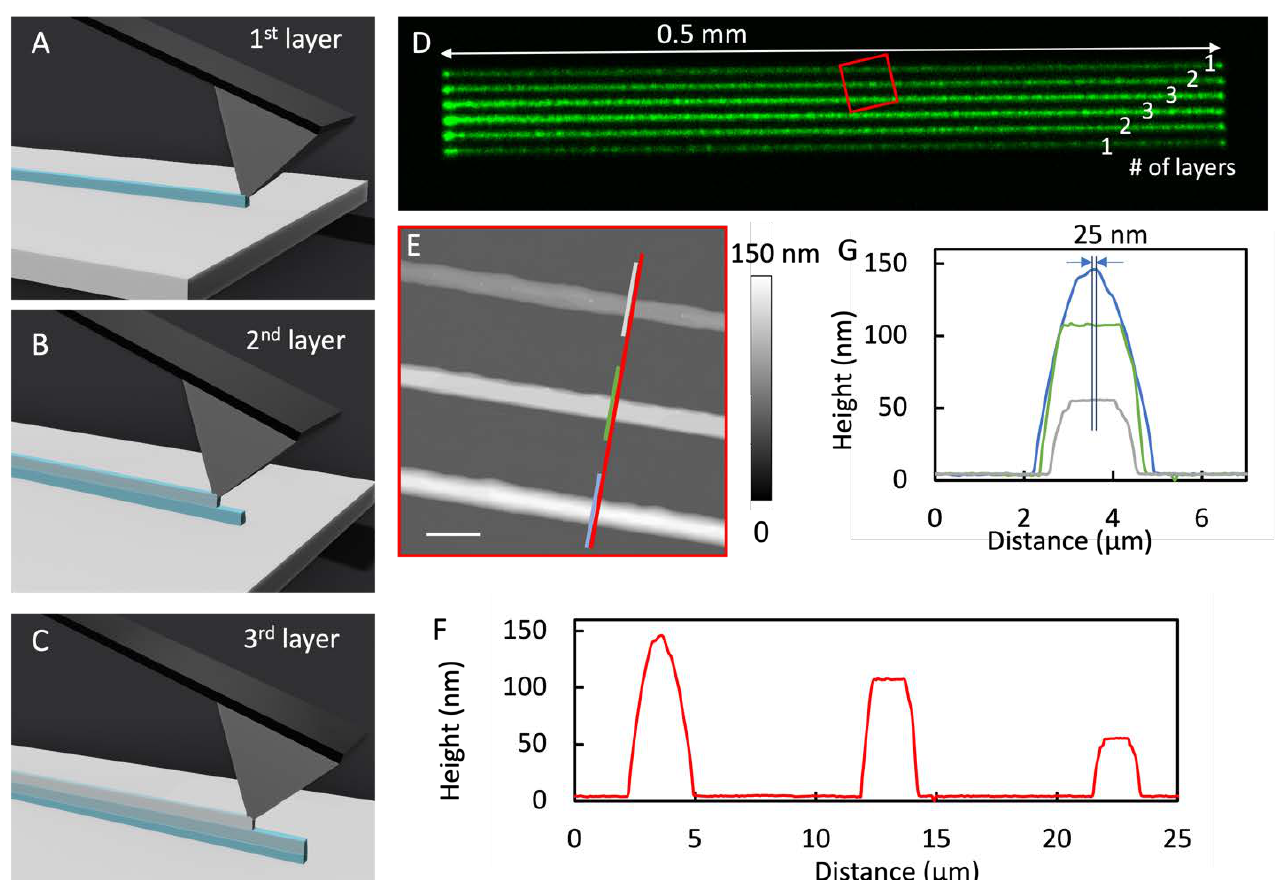
Figure 3. ( A ) Schematic diagram of a cylindrical cap printed with one pass of delivery. ( B ) Schematic diagram of the outcome of a second-pass delivery on top of the first. ( C ) Schematic diagram of the outcome of a third-pass delivery on top of the second. ( D ) Confocal image covering the 0.5 mm × 50 µm feature area that contained all 6 cylindrical caps. The number of passes is indicated on the right. ( E ) Topographic AFM image indicated by the red square in ( D ); scale bar = 5 µm. ( F ) Cursor profile as indicated by the red line in ( E ). ( G ) A combined view of the three cursor plots indicated in ( F ) to measure the interlayer registry, i.e., 25 nm precision.